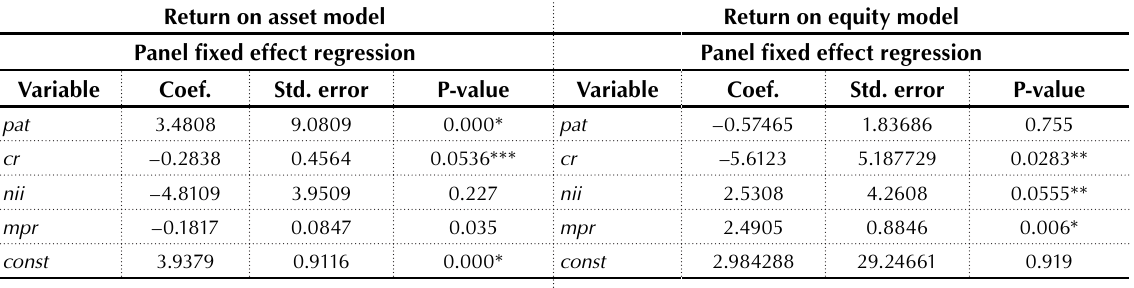
Table 3. Regression model